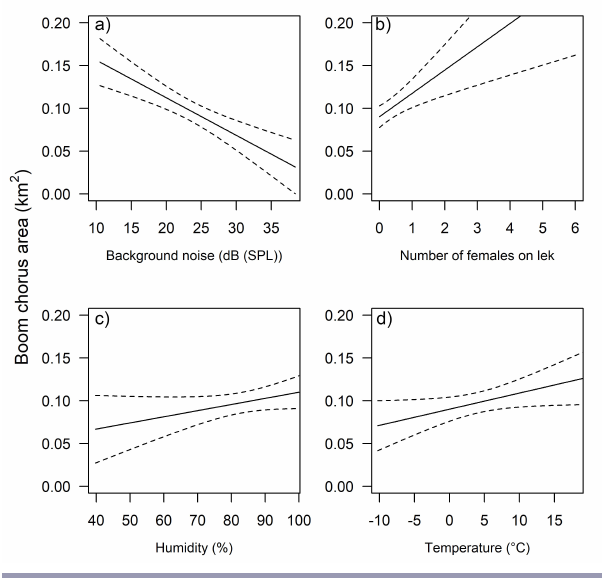
Fig. 4 . Predicted relationship and associated 95% confidence intervals for Greater Prairie-Chicken ( Tympanuchus cupido ) boom chorus propagation area (km²) from models used to assess drivers of chorus propagation based on lek-specific environmental conditions near Ainsworth, Nebraska, 2013 and